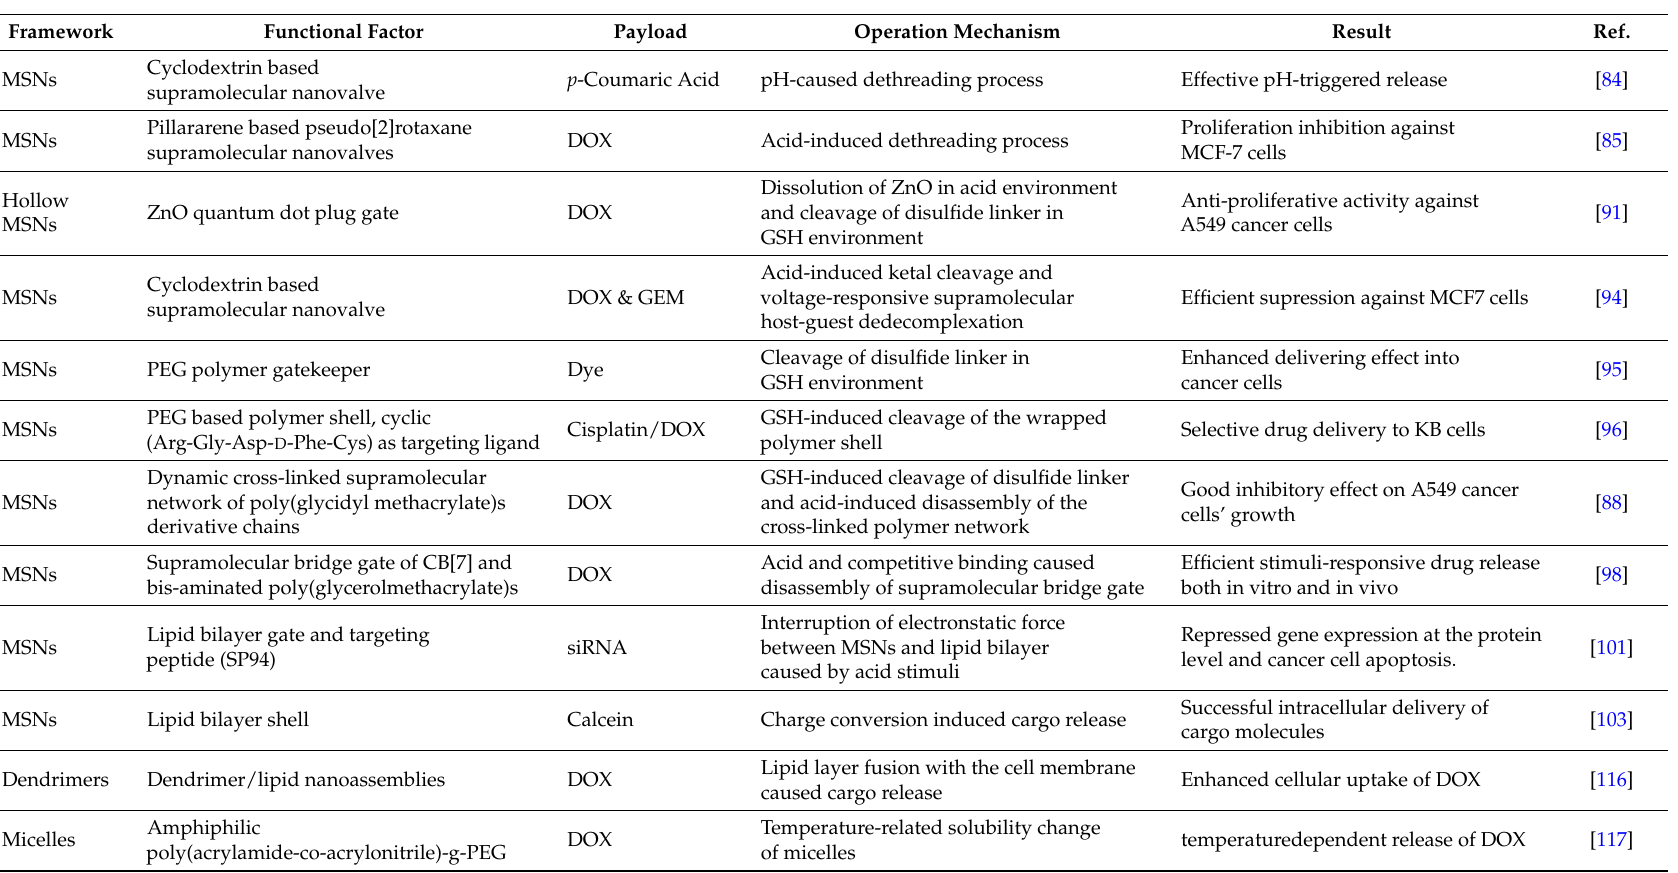
Table 1. Representative stimuli-responsive drug delivery